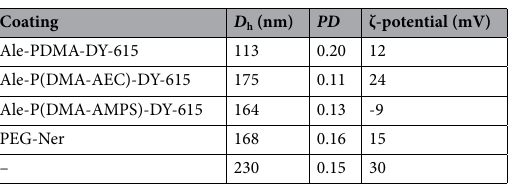
Table 2. Characterization of polymer-coated CS-UCNP. D h - hydrodynamic diameter in water, PD - polydispersity index (DLS); CS-UCNP—NaYF 4 :Yb,Er@NaYF 4